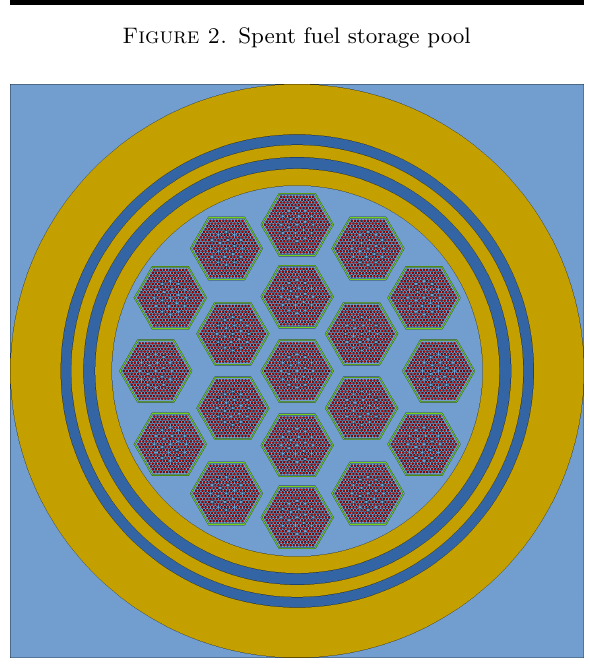
Figure 3. Spent fuel storage cask